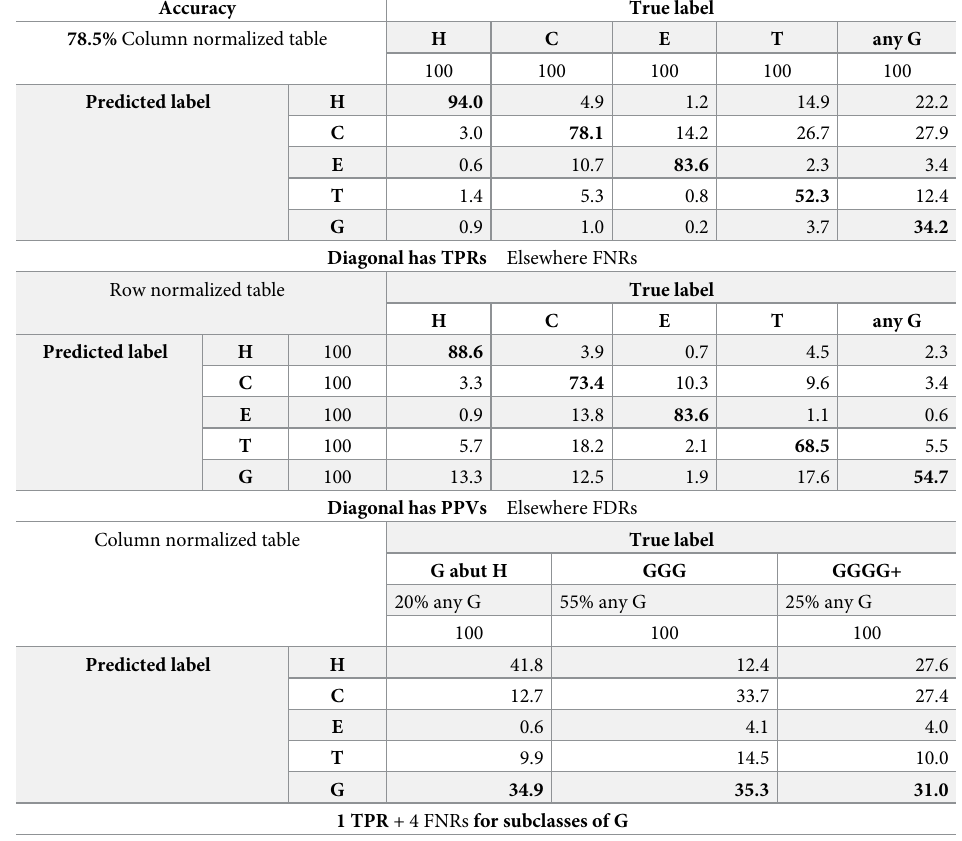
Table 10. 5-label practical alphabet: H , C , E , T , and G : (1) true positive rates (recalls) and false negative rates and (2) positive predictive values (precisions) and false discovery rates of SecNet , (3) TPRs and FNRs for three subclasses of G : (a) G abut HH ... H , (b) isolated GGG in loops and (c) isolated GGGG+ in loops. Accuracy True label 78.5% Column normalized table H any G Predicted label H